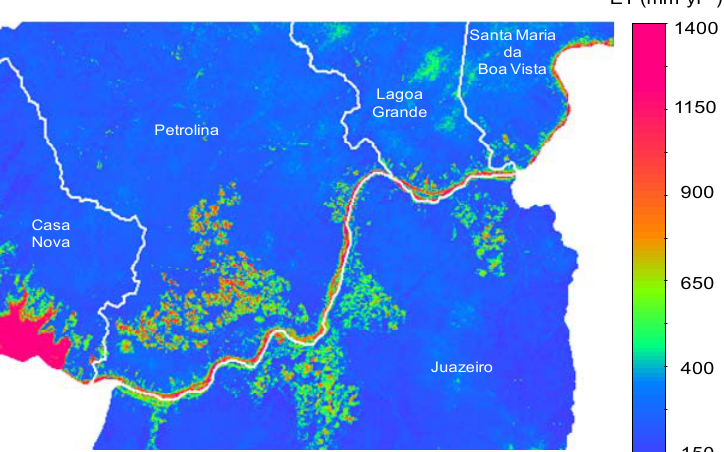
Figure 12. Total annual actual evapotranspiration for 2006 for the region comprised of the net of agro-meteorological stations in the Low-Middle São Francisco river basin.